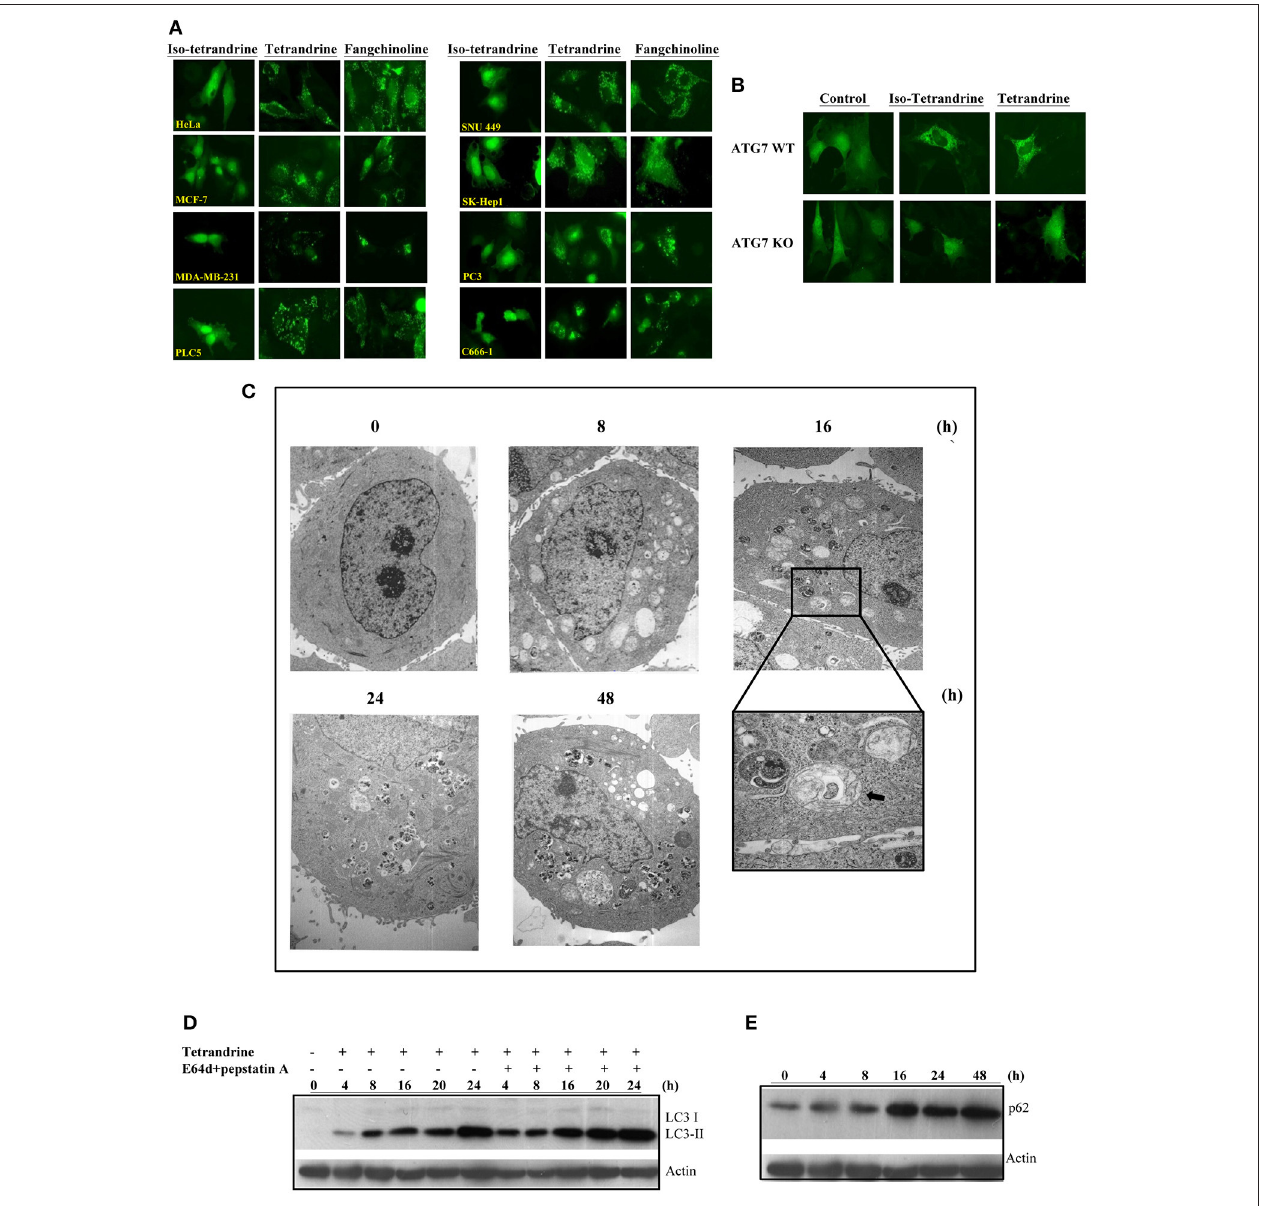
FIGURE 2 | Tetrandrine (Tet) induces autophagy in multiple cell lines. (A) A panel of cancer cells lines expressing GFP-LC3 were treated with the indicated compounds at 5 µ M for 16 h. (B) Both ATG7 + / + wild-type and ATG7 − / − deficient (KO) MEFs were transiently transfected with the GFP-LC3 plasmid for 24 h and then treated with DMSO (Ctrl) or 5 µ M Tet for 16 h. The cells were then fixed for fluorescence imaging and cells counting. Magnification: x63. (C) Representative electron micrographs showing the ultrastructures of MCF-7 cells treated with Tet (5 µ M) for 0–48 h. Magnification: x5600. Arrows, double-membraned autophagosomes. Magnification: x24000. (D) MCF-7 cells were treated with Tet (5 µ M) and lysosomal protease inhibitors (E64d and pepstatin A ) (10 µ g/mL each), either alone or in combination, for 0–24h. Cell lysates were analyzed by western blot for LC3 conversion. (E) Induction of p62 by Tet (5 µ M) in MCF-7 cells. Cell lysates were analyzed by western blot for p62 and β -actin respectively. The results are representative of three independent experiments.